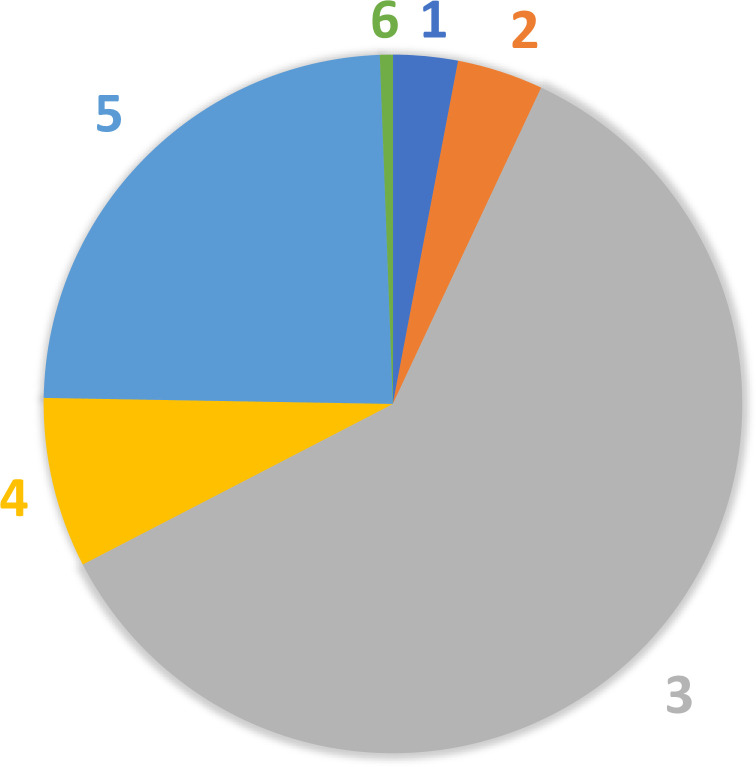
Proportion of taxa falling within six uncertainty/frequency classes (UFC).Approximately 67% of taxa are reliably identified with a high level of certainty (UFC 1–3), and 24.1% (UFC 5) are identified with a low level of certainty. Taxa within UFC 3 and 5 are also considered as rare or having a low frequency of observation.